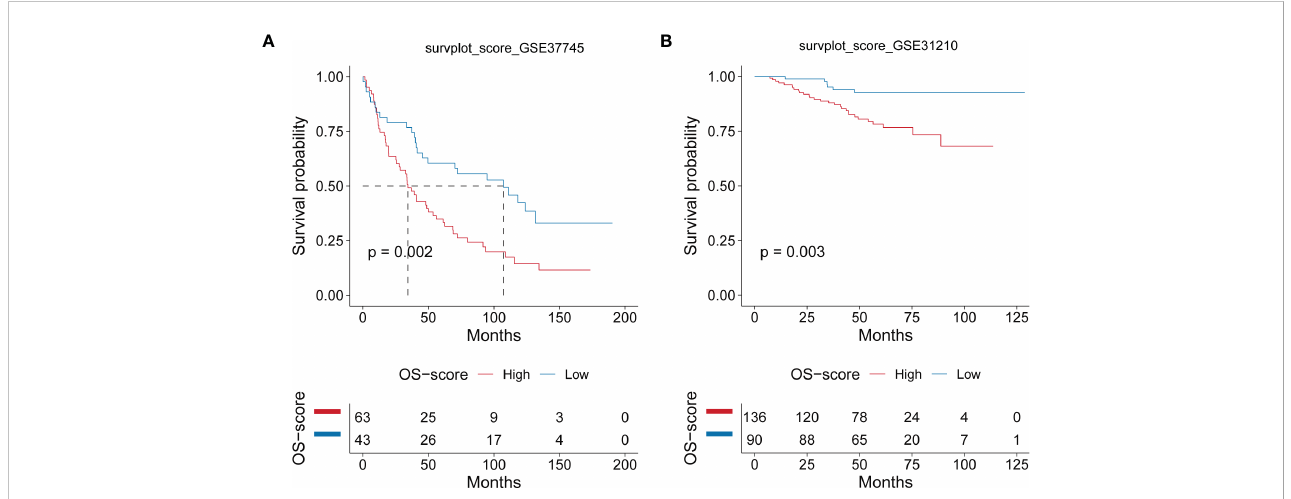
FIGURE 3 Evaluating the ef fi cacy of OS-signature in GEO for LUAD. (A, B) Kaplan-Meier curves displaying the correlation between the OS-score and LUAD patients in GSE37745 (A) and GSE31210 (B) . The blue curve represents the patients with lower OS-score, and the red curve represents patients with higher